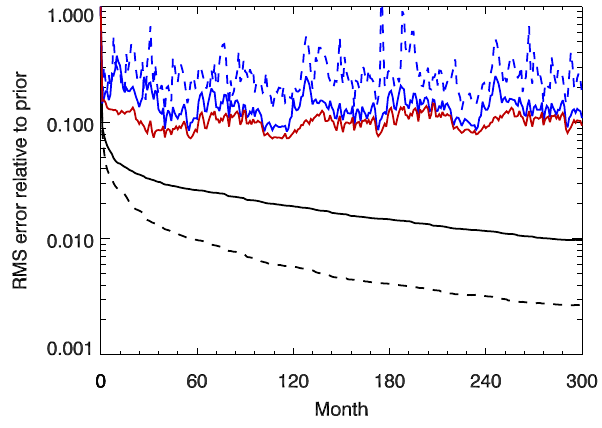
Fig. 6. Evolution of relative RMS error (RMS difference between estimated and true emissions relative to error of prior) for the case of noise free (black) and noisy (color) synthetic observations. Solid lines are for inversions with a transport uncertainty of ρ srr = 0 . 8 , dashed lines for a lower uncertainty of ρ srr = 0 . 2 . Inversion set- tings for the noisy case (blue lines) are identical to those for the noise free case (black). The red line is for an inversion identical to the blue solid line but applying the augmented state red-noise Kalman filter.